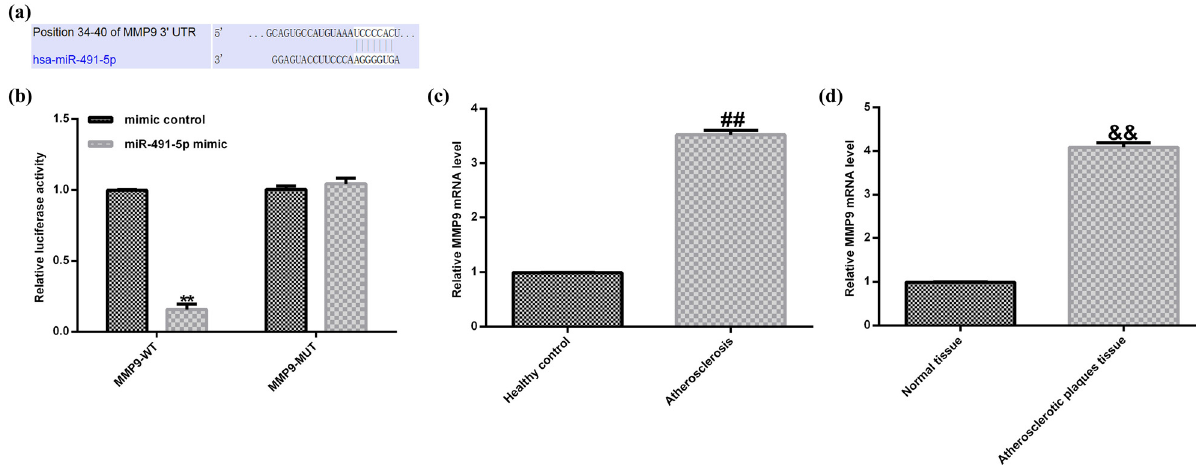
Figure 2: The expression of miR - 491 - 5p that directly targets MMP - 9 and MMP - 9 was upregulated in the atherosclerotic tissues and plasma. ( a ) The predicted miR - 491 - 5p binding site in the 3 ′ - UTR of MMP - 9. ( b ) The dual - luciferase analysis was used to con fi rm the binding sites between miR - 491 - 5p and 3 ′ - UTR MMP - 9. ( c ) Expressions of MMP - 9 at mRNA level in the plasma samples of the patients with atherosclerosis were detected by qRT - PCR. ( d ) Expressions of MMP - 9 at mRNA level in atherosclerotic plaque tissues were detected by qRT - PCR. The data are expressed as mean ± SD; ** p < 0.01 vs. mimic control; ## p < 0.01 vs. healthy control; && p < 0.01 vs. normal